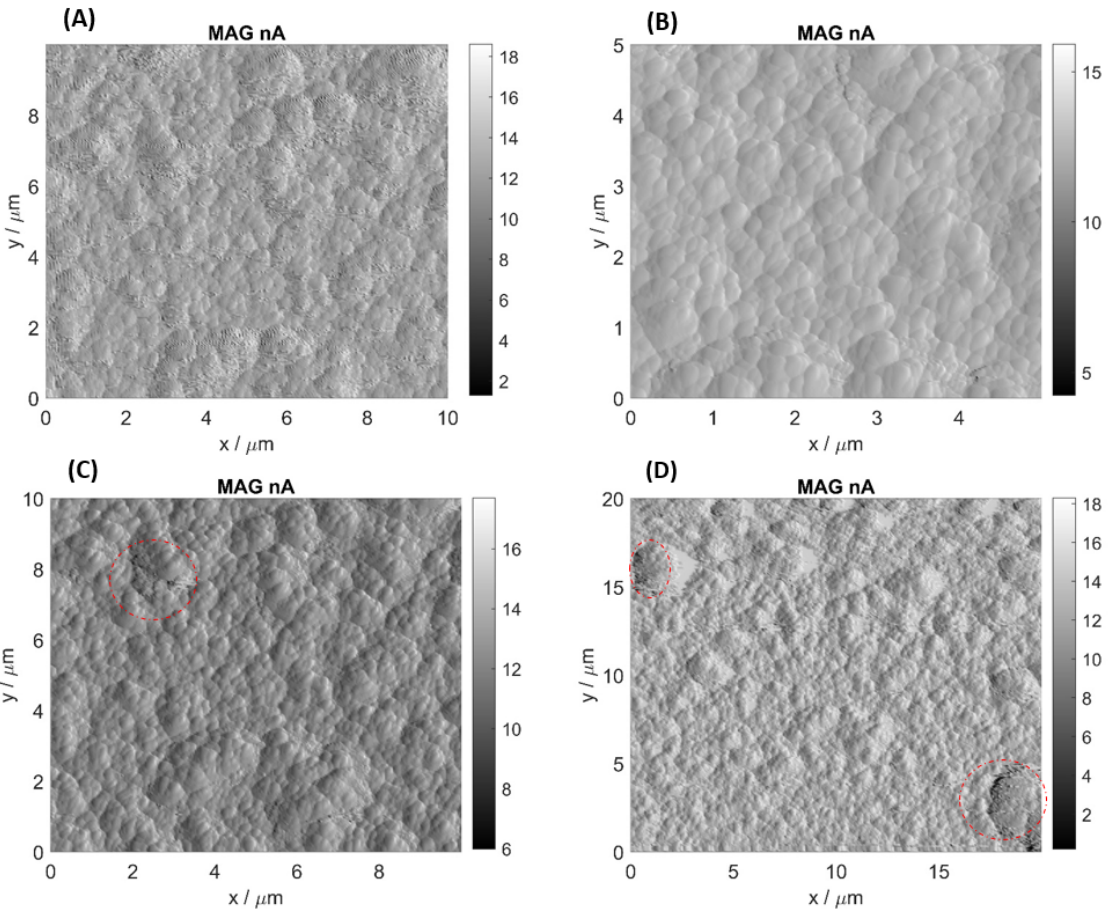
Figure 5. AFM images of QCM resonators: ( A ) with deposited OBPP4 and after ( B ) electrochemical cleaning, ( C ) plasma cleaning and ( D ) Piranha cleaning (surface defects are highlighted in red).